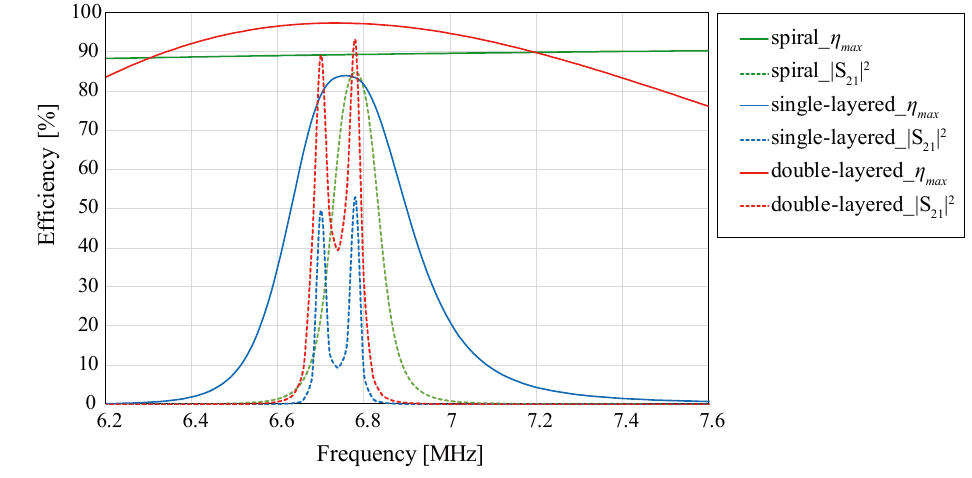
Figure 6. Frequency characteristics of transfer efficiency.